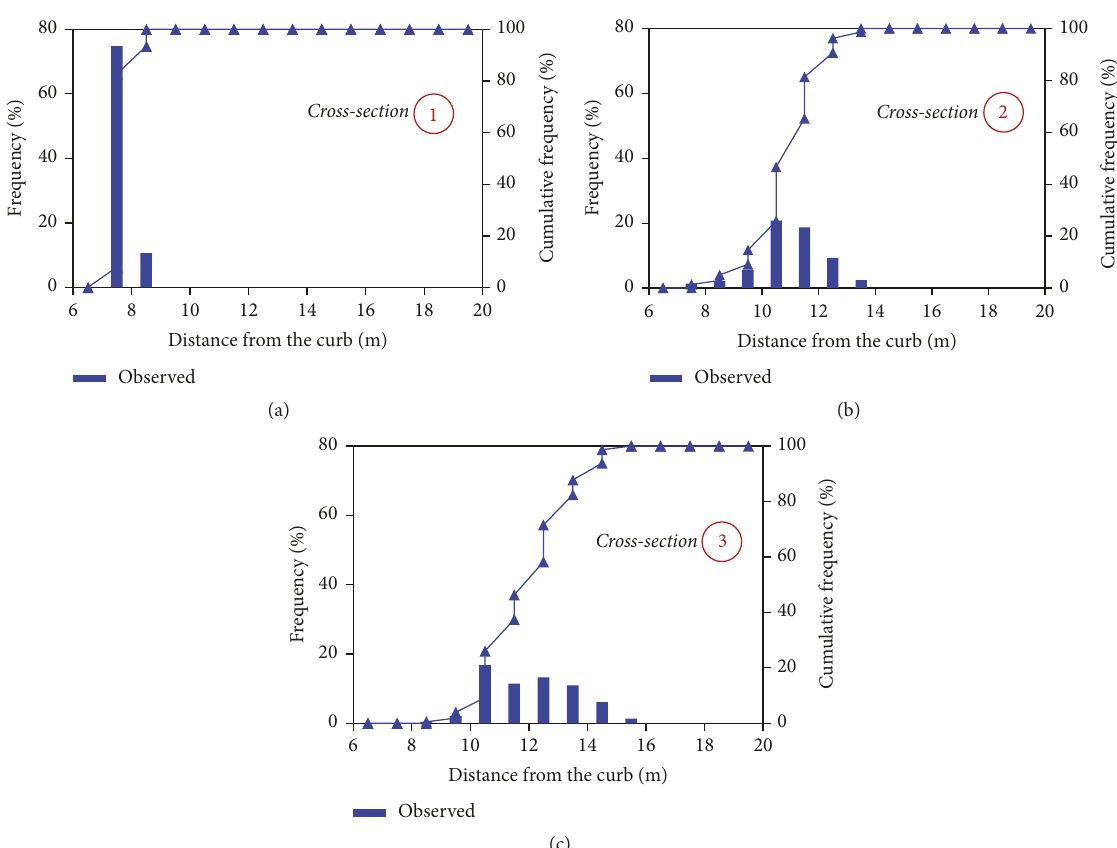
Figure 9: Comparison of extracted right-turn vehicle trajectories at cross-sections.